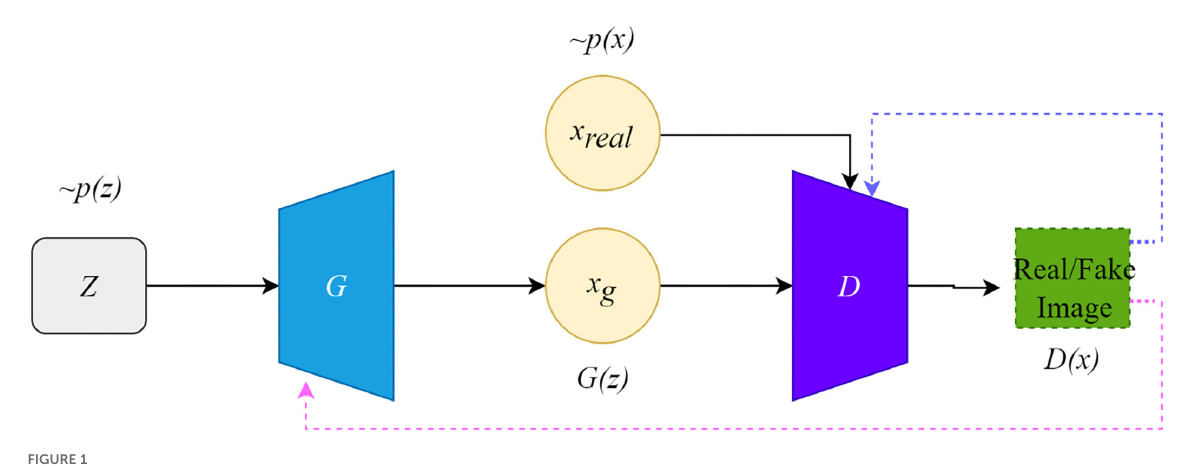
FIGURE1 The architecture of the original